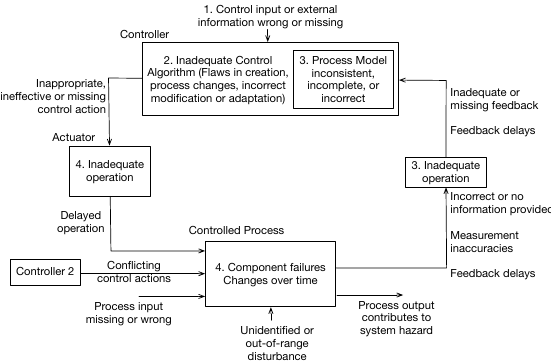
Figure 4. A classification of controls flaws leading to system